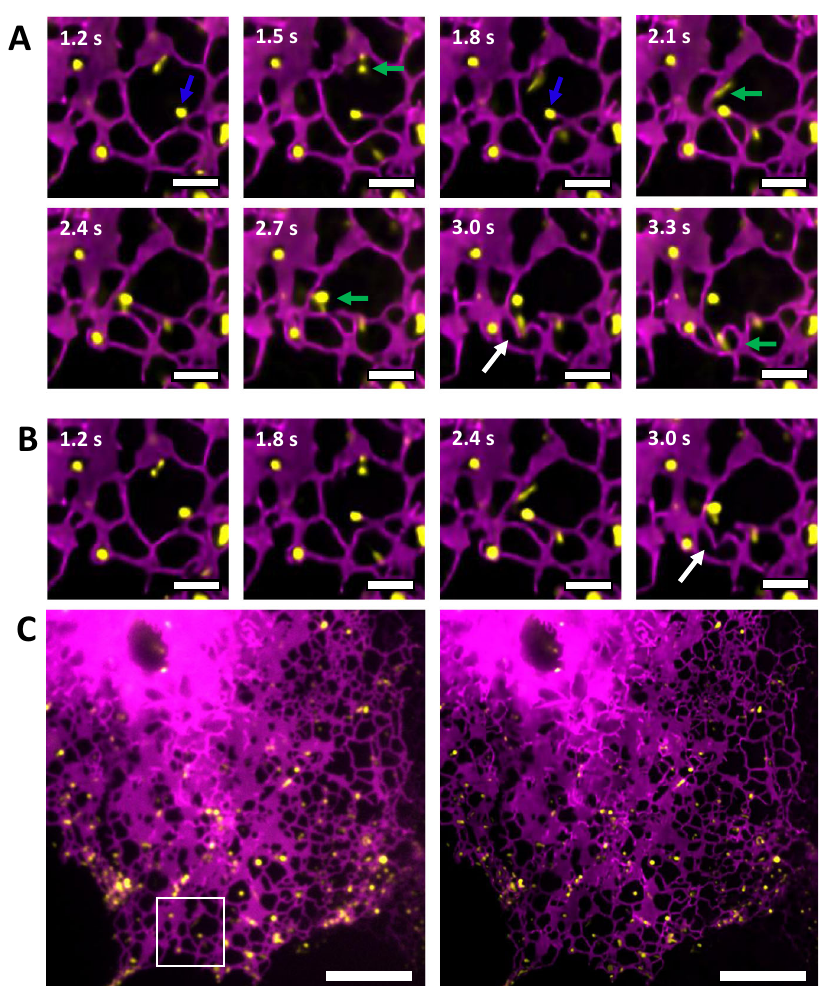
Fig.7|SimultaneousimagingwithMAI-SIMimprovestemporalresolutionand image reliability. COS7 cells stained with SiR-lysosome (yellow) and transfected withmApple-Sec61b-C1tolabeltheendoplasmicreticulum(ER)(magenta). A Time series of two ER network reorganization events visualized with MAI-SIM. One lysosome(bluemarker)canbeseento pullanew fi lamentfrom thenetworkwhich failstomakeaconnectionandissubsequentlyreleased.Asecondlysosome(green marker) moves rapidly along the ER network and cleaves an ER fi lament (white